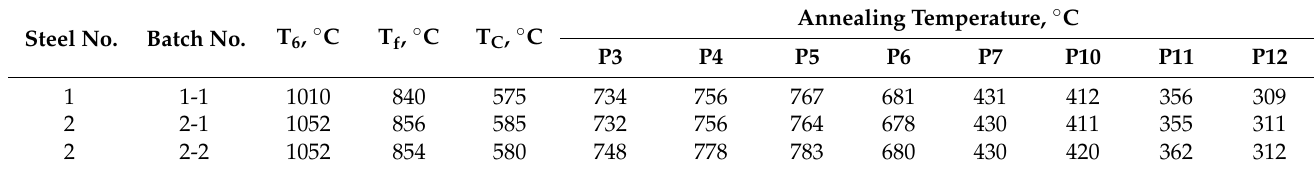
Table 2. Parameters of hot rolling and processing of rolled products in